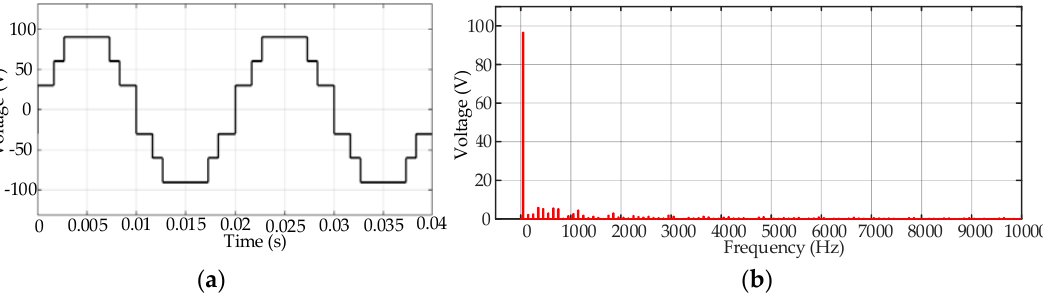
Figure 9. Output of the MLI in Mode I under no-load condition ( a ) Voltage waveform ( b ) its corresponding harmonics spectra. THD is 15.5%.